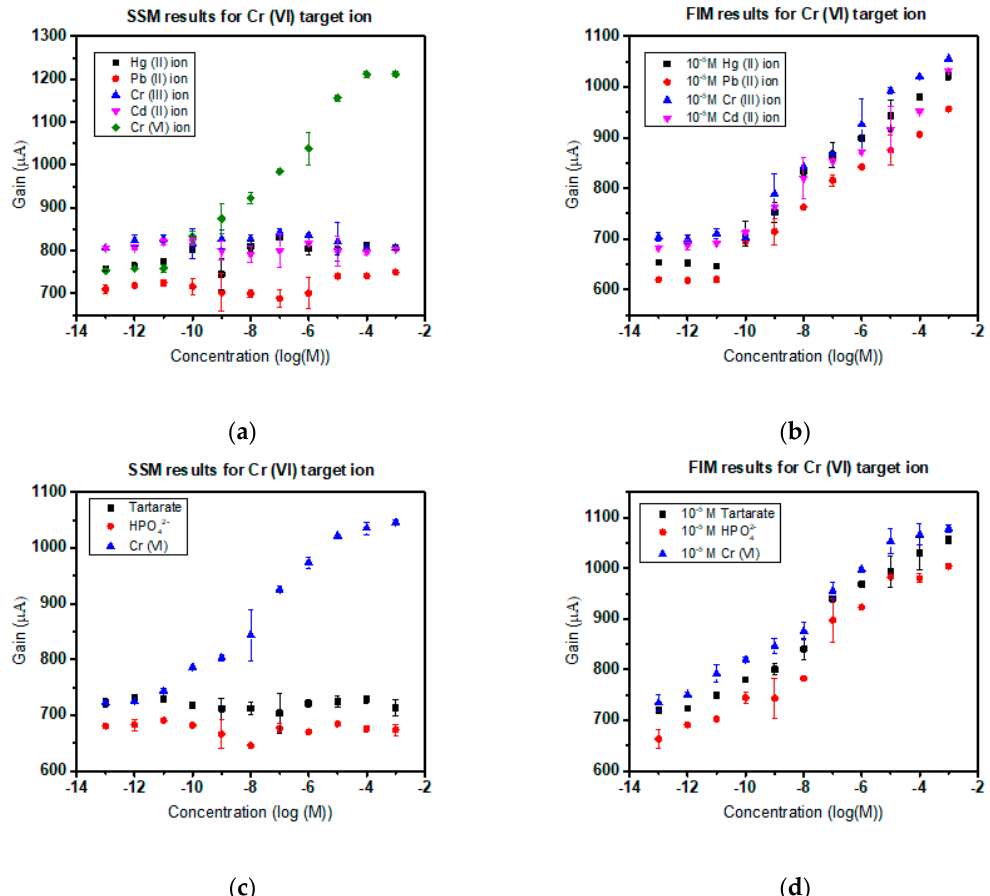
Figure 8. ( a ) Cr(VI) ISMFET SSM selectivity characteristics depicting target-specific interaction of Cr(VI) with ionophore; ( b ) Cr(VI) highly selective FIM characteristics in presence of interfering cations; ( c ) SSM selectivity of Cr(VI) sensor in presence of anions tartrate and phosphate; ( d ) FIM selectivity characteristics of chromate specific sensor in environment of relatively higher concentration of anions tartrate and